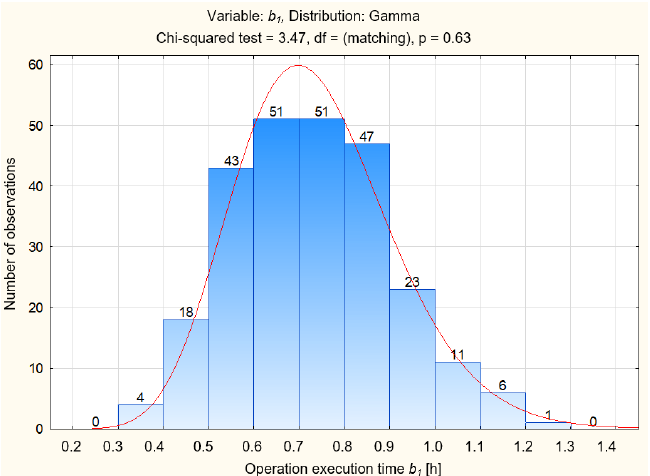
Figure 7. Histogram of the frequency of occurrence of operation b 1 according to pre ‐ set time inter ‐